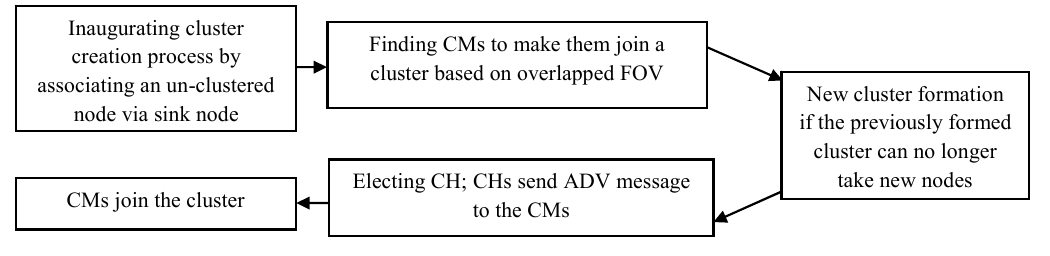
Figure 5. Cluster formation process in EGR.